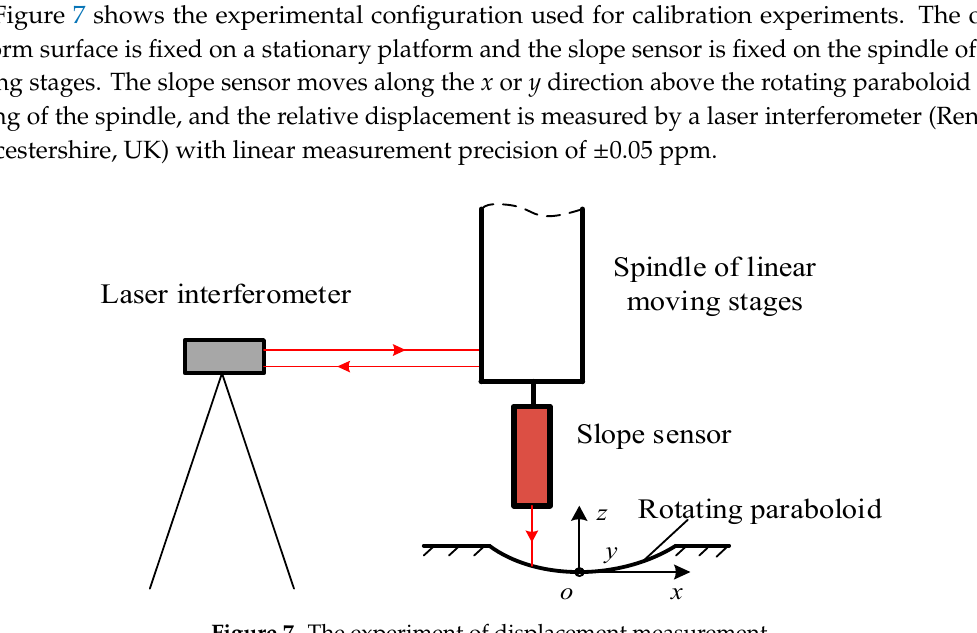
Figure 7. The experiment of displacement measurement.